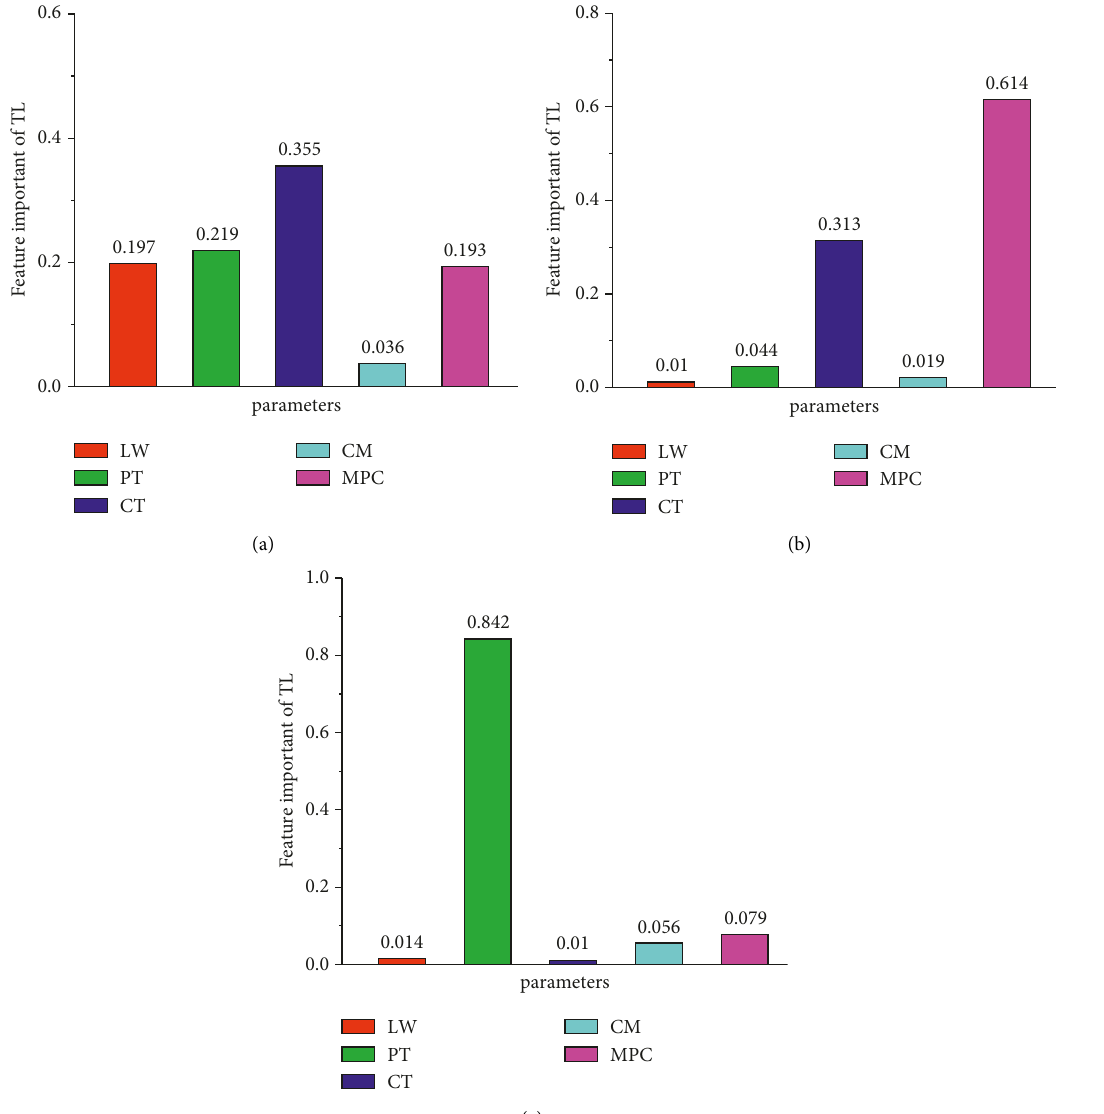
Figure 15: The weight of each parameter in the medium- and high-frequency domain of (a) 2000Hz; (b) 2500Hz; and (c)